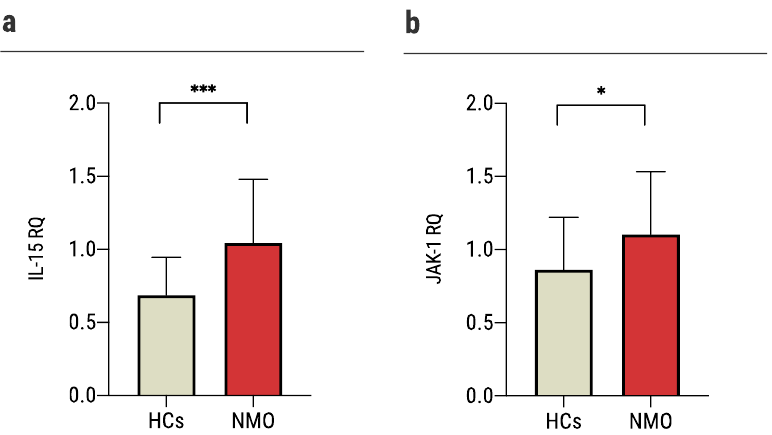
Figure 7. Sera of NMO patients stimulates repair process. Quantitative PCR gene expression analysis of: ( a ) the expression of IL-15 increased significantly in astrocytes cultured with sera of NMO patients (1.1 ± 0.5, n = 31) vs. 0.72 ± 0.3 ( n = 24) of astrocytes cultured with sera of HCs, ( b ) the expression of JAK-1 increased significantly in astrocytes cultured with sera of NMO patients (1.1 ± 0.4, n = 32) vs. 0.86 ± 0.4 ( n = 24) of astrocytes cultured with sera of HCs. Each assay was repeated independently at least three times. Significance was determined by unpaired two-tailed student’s t -test ( p * ≤ 0.05, *** ≤ 0.001). Error bars in all graphs represent standard deviation.